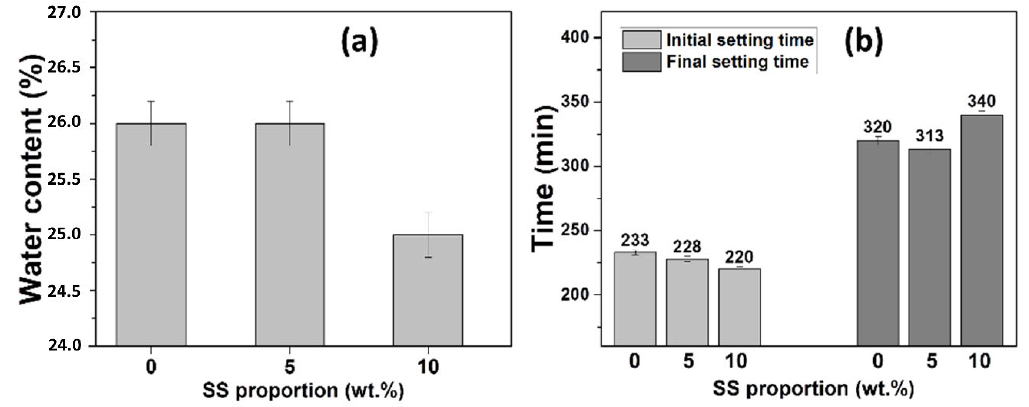
Figure 9. ( a ) Flow time and ( b ) SS mortars setting time.